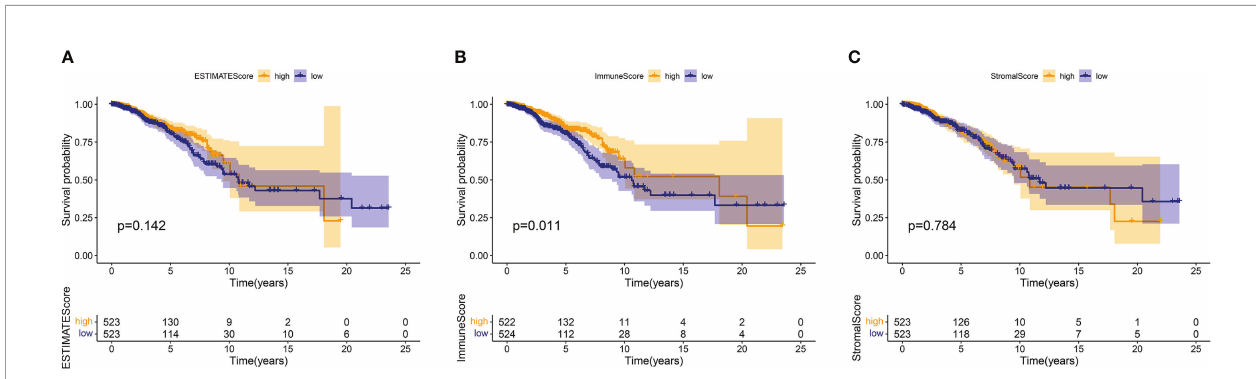
FIGURE 1 | The relations between the survival and ESTIMATE Score, Immune Score, and Stromal Score in patients with BC. The Kaplan – Meier survival analysis was performed for ESTIMATE Score ( p = 0.142), Immune Score ( p = 0.011), and Stromal Score ( p = 0.784), respectively. Comparisons were conducted in the high and low score groups and presented in orange and blue,